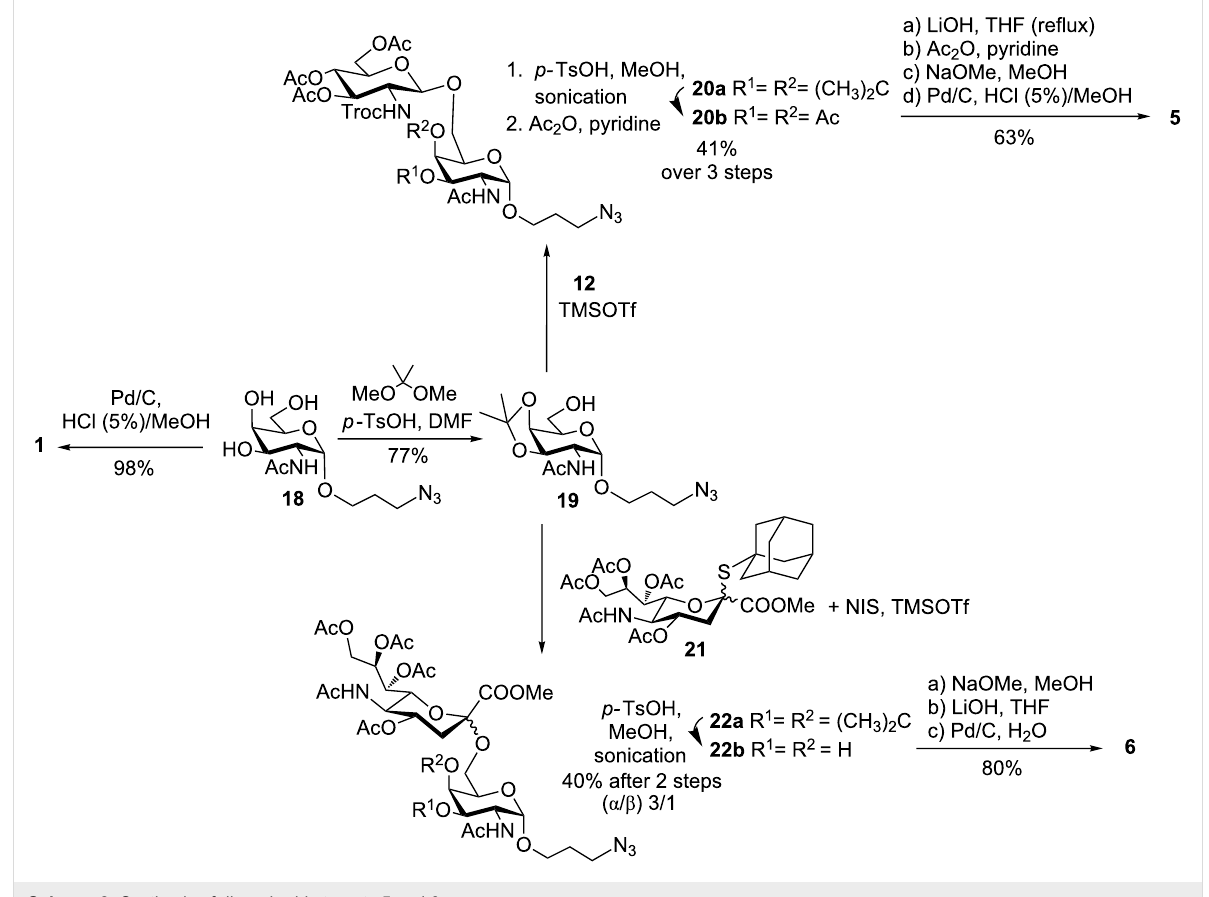
Scheme 2: Synthesis of disaccharide targets 5 and 6